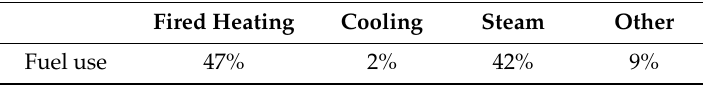
Table A5. The shares of fuel directly used in the